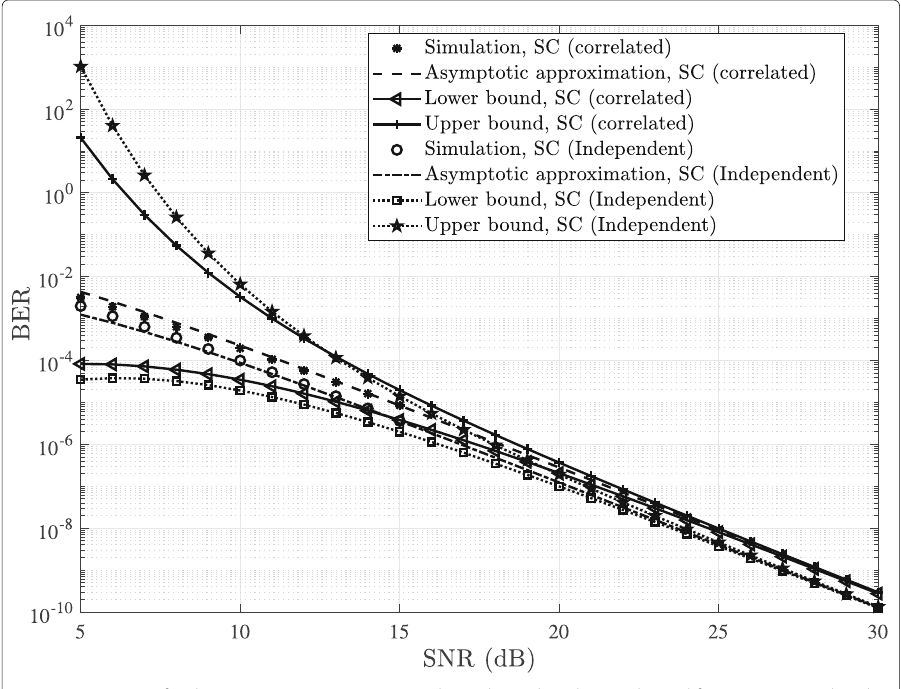
Fig. 8 BER curves for the asymptotic approximation, lower bound, and upper bound for SC, over correlated and independent BX fading channels. The number of branches is N = 2, the fading parameter is m = 1.5, and (cid:12) C 1 , 0 2 × 2 , 0 2 × 2 ; 0 2 × 2 , C 2 , 0 2 × 2 ; 0 2 × 2 , 0 2 × 2 , C 3 the correlation structures is C b =